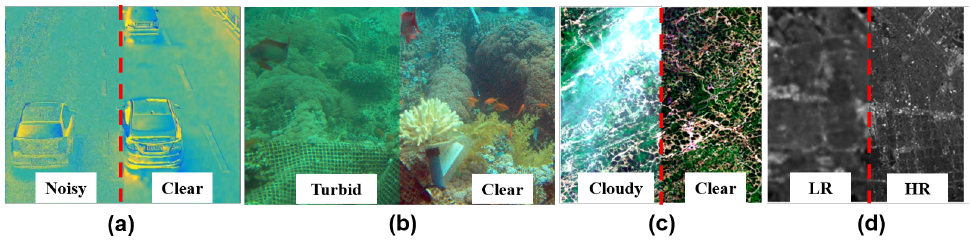
Figure 1. Scenes ( a ) with/without noise ( b ) turbidity or ( c ); ( d ) with low-resolution (LR) or high- resolution (HR)